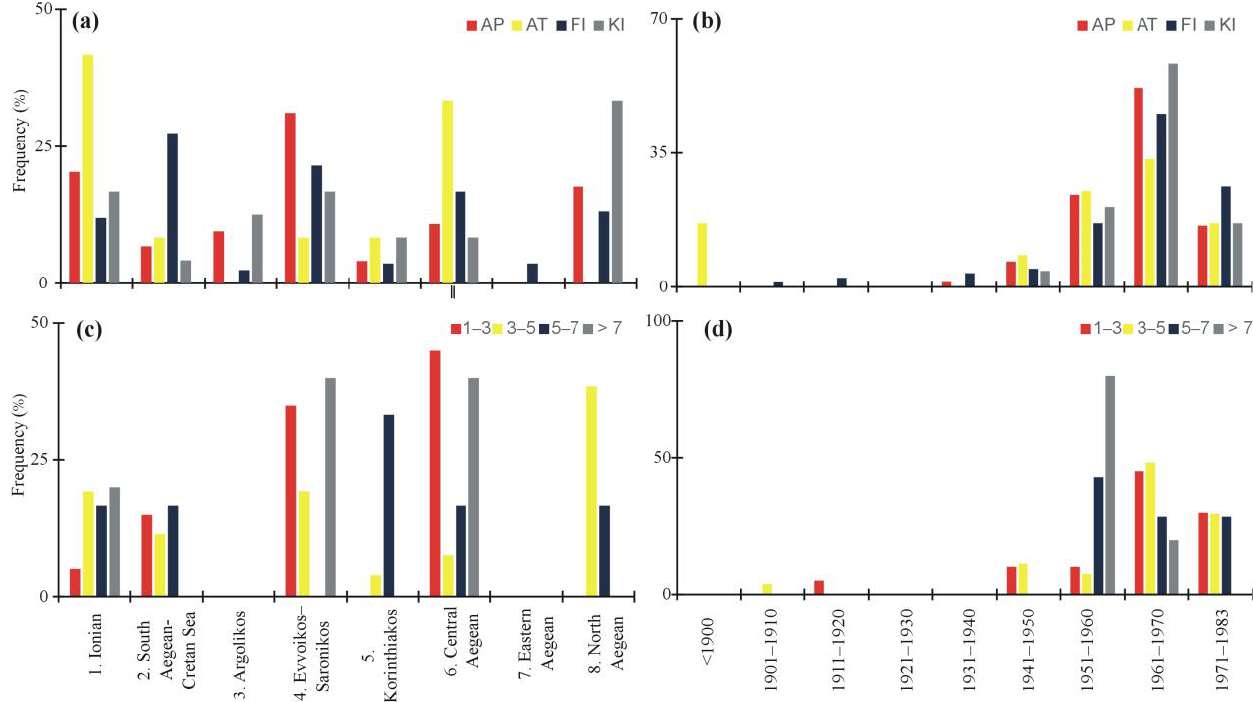
Figure 2. Percentage contribution (%) of shark reports per area and year period in terms of: ( a , b ) type of reporting and ( c , d ) reported length class (in m). Record type: AP, appearance; AT, attack; FI, fishery; and KI, deliberate killing.